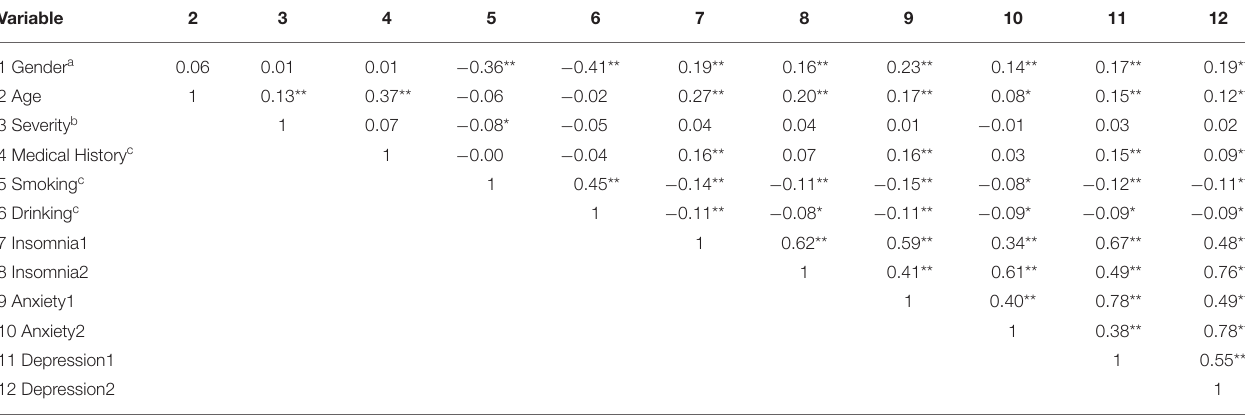
TABLE 3 | Correlation analysis among variables. Variable